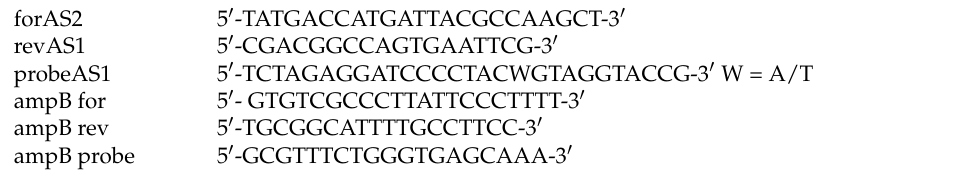
Table 1. PCR primers used in the quantitative transposon excision